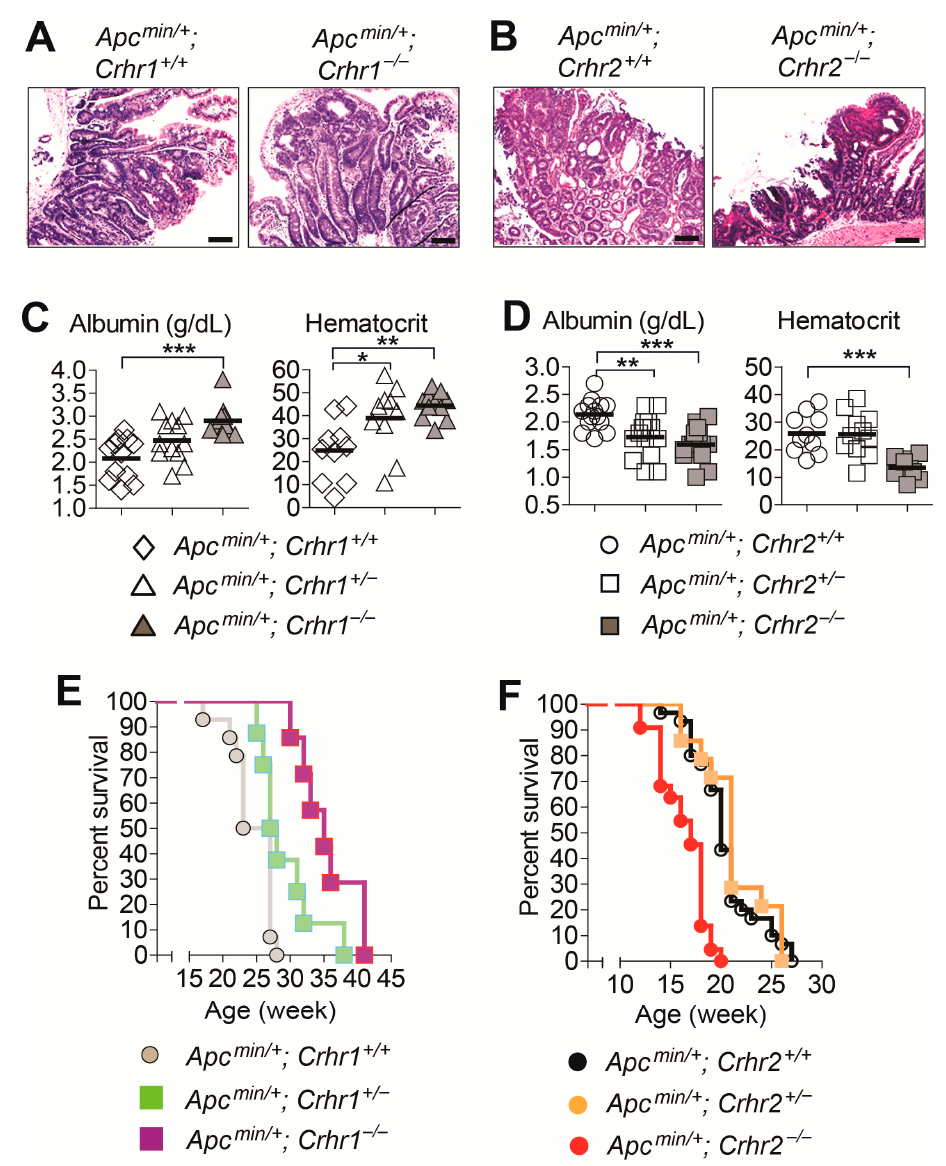
Figure 3. Crhr1 deletion reduces the severity of intestinal tumorigenesis in Apcmin/+ mice, whereas Crhr2 deletion worsens the disease severity. ( A , B ) Histopathology of intestinal tumor tissues were visualized by hematoxylin & eosin (H&E) staining (scale bars, 100 µ m). ( C , D ) Serum albumin and hematocrit levels were analyzed using mouse blood samples. Apcmin/+; Crhr1 +/+ (n = 10–12), Apcmin/+; Crhr1 +/ − (n = 10–12), Apcmin/+; Crhr1 − / − (n = 11–12), Apcmin/+; Crhr2 +/+ (n = 10–14), Apcmin/+; Crhr2 +/ − (n = 11–14), Apcmin/+; Crhr2 − / − mice (n = 10–15). * p < 0.05, ** p < 0.01, *** p < 0.001 (one-way ANOVA). ( E , F ) The mouse mortality was evaluated over 10 months after birth. Difference in survival was analyzed by a Kaplan–Meier plot. The log-rank (Mantel–Cox) test was used to compare significant survival difference ( p = 0.0008 in E , p = 0.0002 in F ). Data were analyzed with the results accumulated by 3 independent experiments. Apcmin/+; Crhr1 +/+ (n = 14), Apcmin/+; Crhr1 +/ − (n = 8), Apcmin/+; Crhr1 − / − (n = 8), Apcmin/+; Crhr2 +/+ (n = 30), Apcmin/+; Crhr2 +/ − (n = 13), Apcmin/+; Crhr2 − / − mice (n =